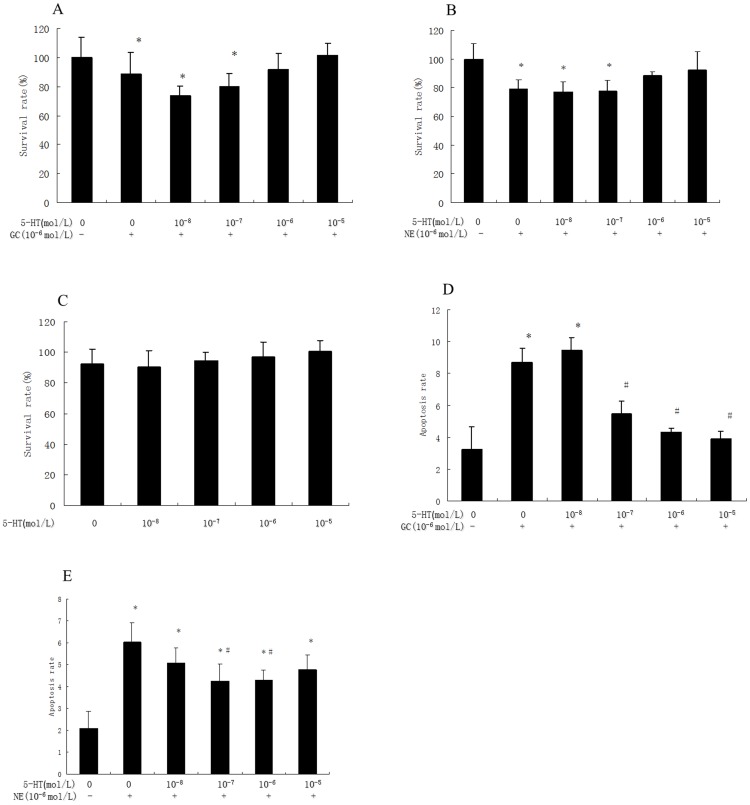
5-HT-induced cardiomyocyte injury required the presence GC or NE in vitro.An MTT (3-(4,5-dimethylthiazol-2-yl)-2,5-diphenyltetrazolium bromide) assay was utilized to detect cell viability. 5-HT (10−5, 10−6, 10−7 and 10−8 M) was used to treat cultured cardiomyocytes with 10−6 M GC or 10−6 M NE. A. The cell viability of cardiomyocytes treated with 10−8 M 5-HT and 10−6 M GC decreased significantly compared with the control. B. The cell viability of cardiomyocytes treated with 10−8 M 5-HT and 10−6 M NE decreased significantly compared with the control. C. The cell viability of cardiomyocytes treated with only 5-HT was not changed significantly compared with the control. D. The apoptosis rate of cardiomyocytes treated with 5-HT and 10−6 GC increased significantly compared with the control. E. The apoptosis rate of cardiomyocytes treated with 5-HT and 10−6 NE increased significantly compared with the control. Values represent the group mean ± structural equation modeling (SEM) (n = 8 rats per group). *P<0.05 compared with control, repeated measures ANOVA followed by Tukey’s multiple comparison test.